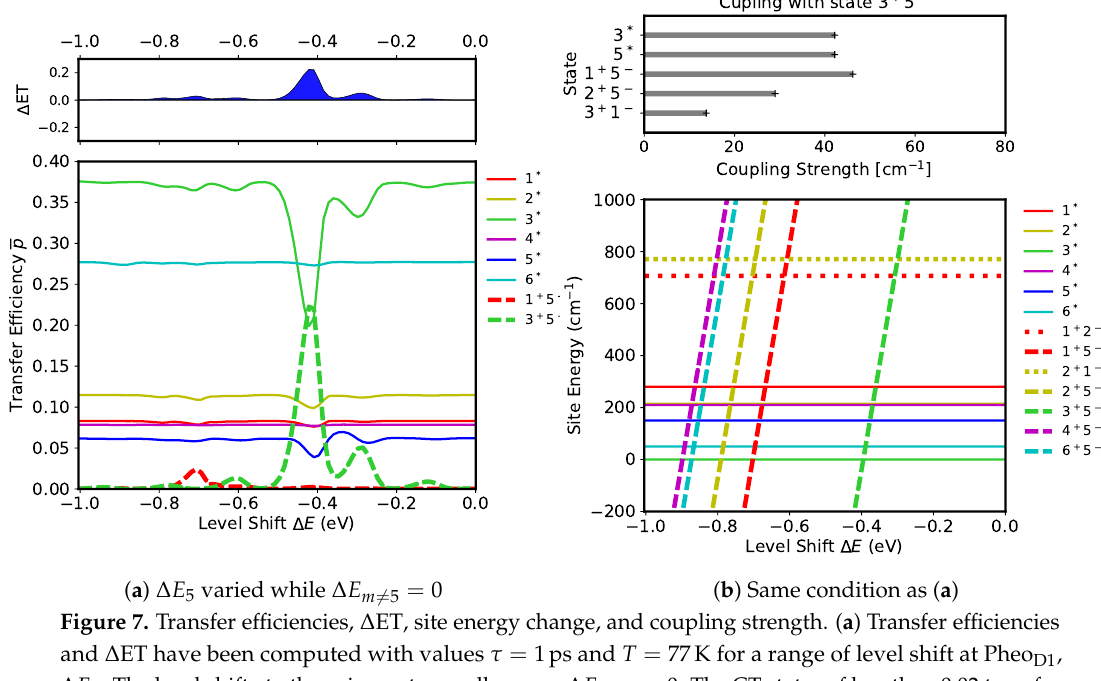
Figure 7. Transfer efficiencies, ∆ ET, site energy change, and coupling strength. ( a ) Transfer efficiencies and ∆ ET have been computed with values τ = 1ps and T = 77K for a range of level shift at Pheo D1 , ∆ E ∆ E = 0. The CT states of less than 0.02 transfer 5 . The level shift at other pigments are all zero as m (cid:54) = 5 efficiencies are not displayed. ( b ) The site energies ε mn are shown for the values of ∆ E 5 . The top panel shows the major states coupled with | 3 + 5 − (cid:105) , extracted from Figure 5b for those above 10cm − 1 .